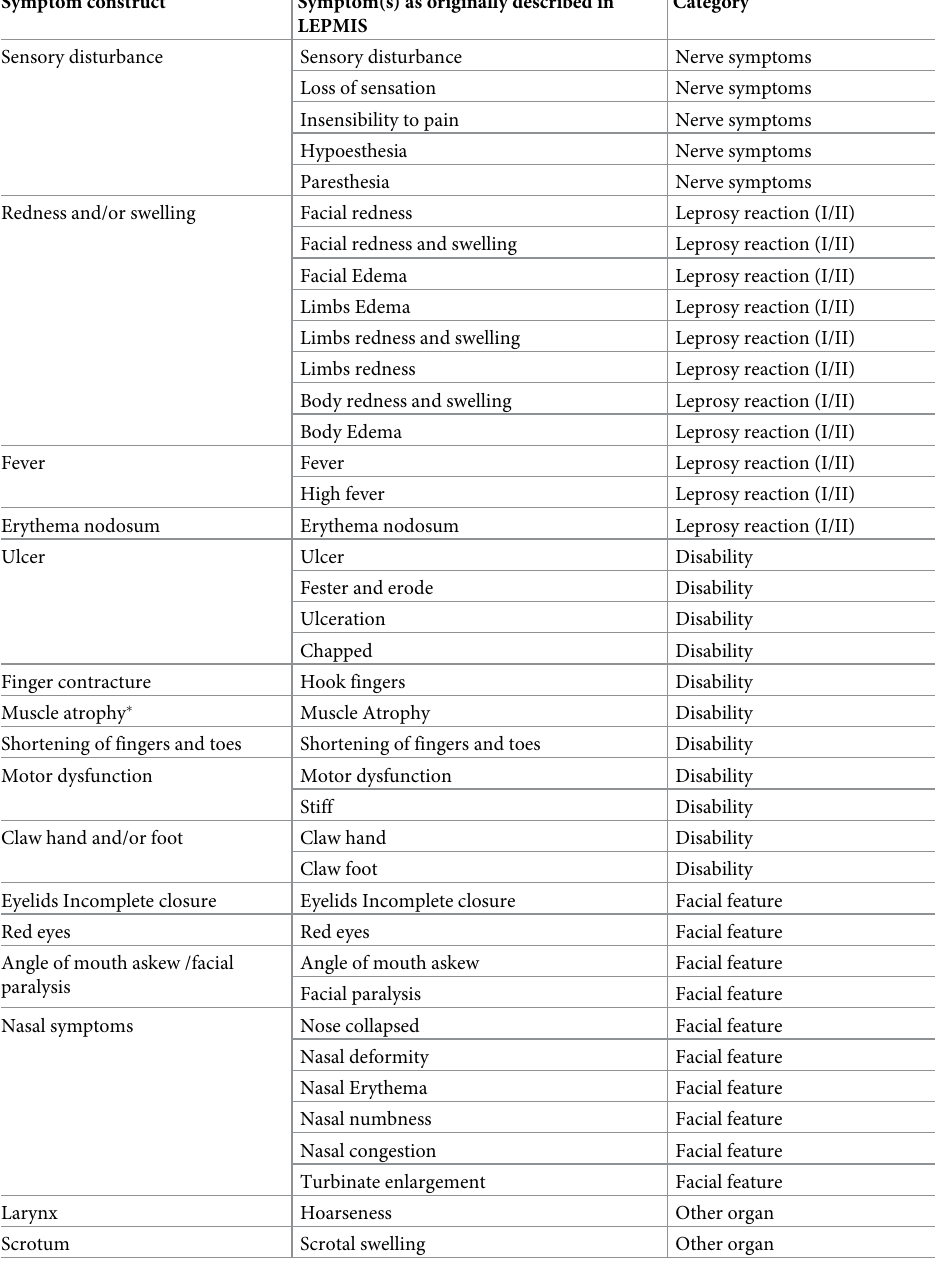
features (Table 2). The predominant symptoms were skin symptoms (n = 2533, 50.66%), fol- lowed by nerve symptoms (n = 1775, 35.50%), disability (n = 316, 6.32%), and leprosy reac- tions (n = 297, 5.94%) (Table 3). Symptoms related to skin (1935/2533, 76.39%) and leprosy reactions (279/297, 93.94%) mainly occurred in the MB group. Symptoms related to